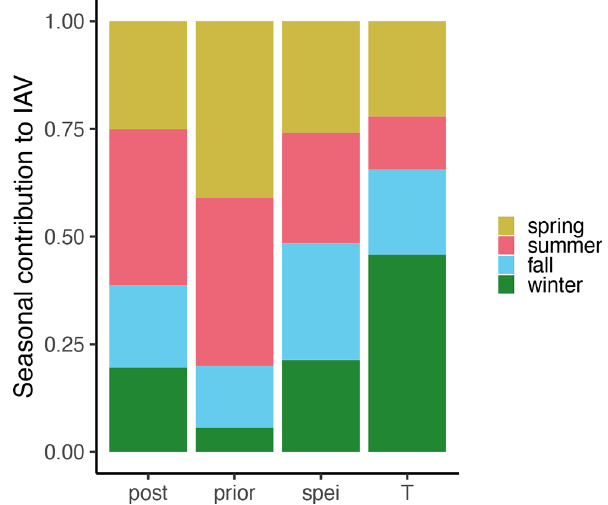
Figure 10. Seasonal contribution to IAV calculated relative to 14 years for posterior NEE fluxes (post), VPRM NEE fluxes (prior), SPEI, and T during the four seasons over the full